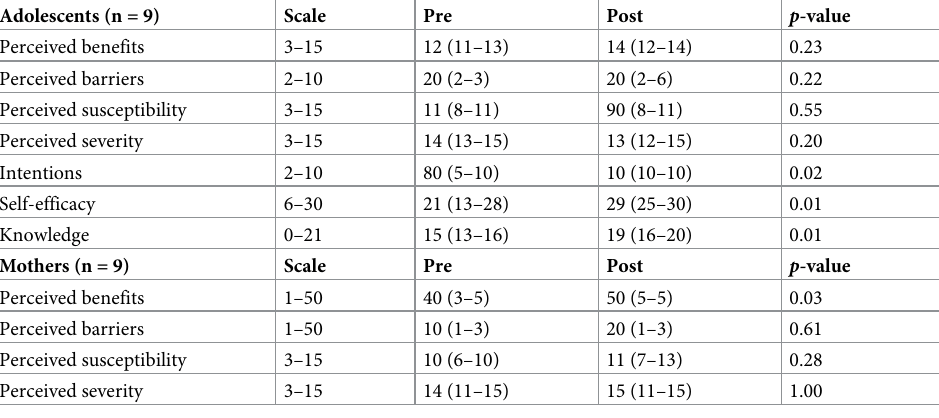
Shown as median (interquartile